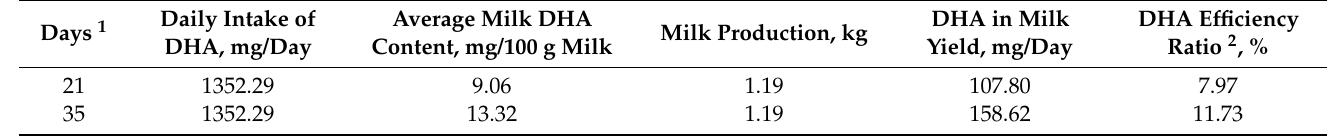
Table 5. Calculated docosahexaenoic acid (DHA) conversion efficiency from diet to